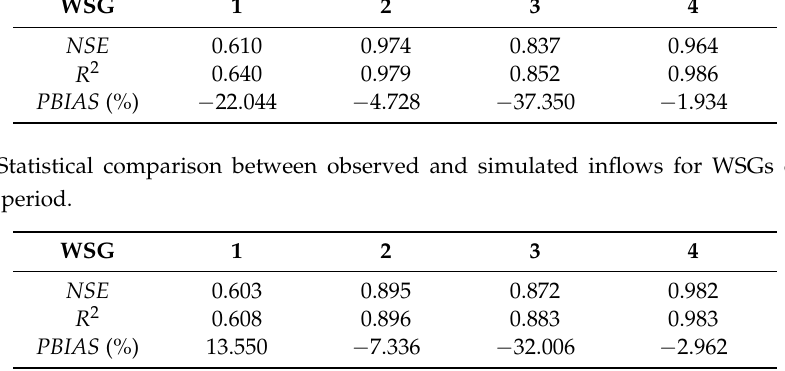
Figure 7. Comparison of observed and simulated inflows for WSGs during the calibration period. Table 3. Statistical comparison between observed and simulated inflows for WSGs during the calibration period.